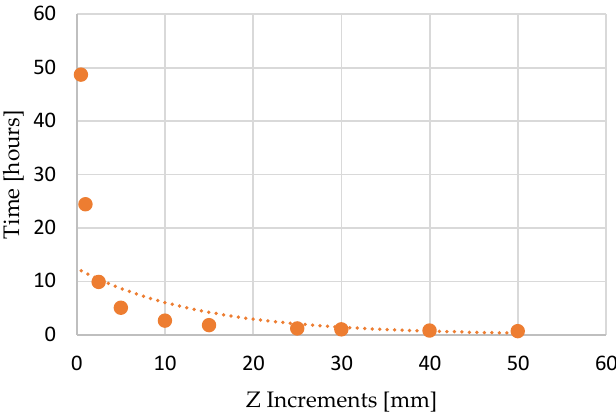
Figure 23. Influence of Z -axis increments with constant 10 mm X increments (with exponential fitting).